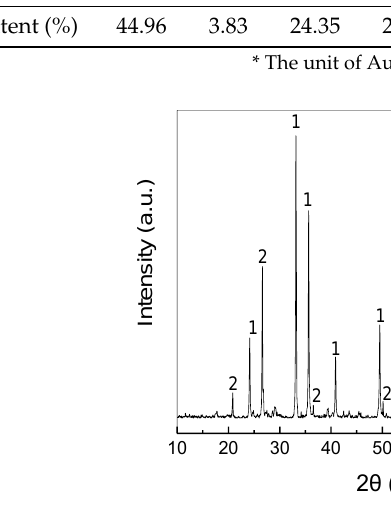
Figure 1. XRD pattern of received cyanide tailings.